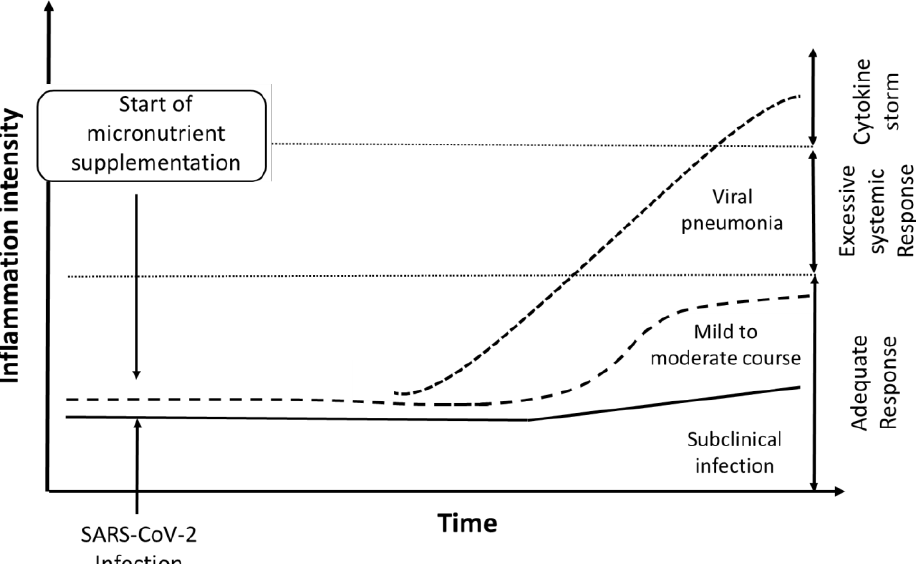
Figure 1. Hypothesized effect of supplements (Zn, Se, and vitamin D) on intensity of inflammation in patients with COVID-19: A severe course of the disease, which may occur in cases with pre-infectious low-grade inflammation and inadequate status of micronutrients, is characterized by an escalation of the inflammation into a cytokine storm (dotted line). Supplementation with Se, Zn, and vitamins when given at an early stage after infection is anticipated to act protectively by improving immune reactivity and supporting adequate inflammatory response, leading to lower risk of cytokine storm and less severe course of COVID-19, as indicated by the dashed line.